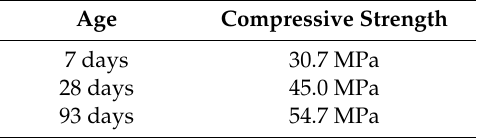
Table 2. Compressive strength determined on cubes with a side of 150